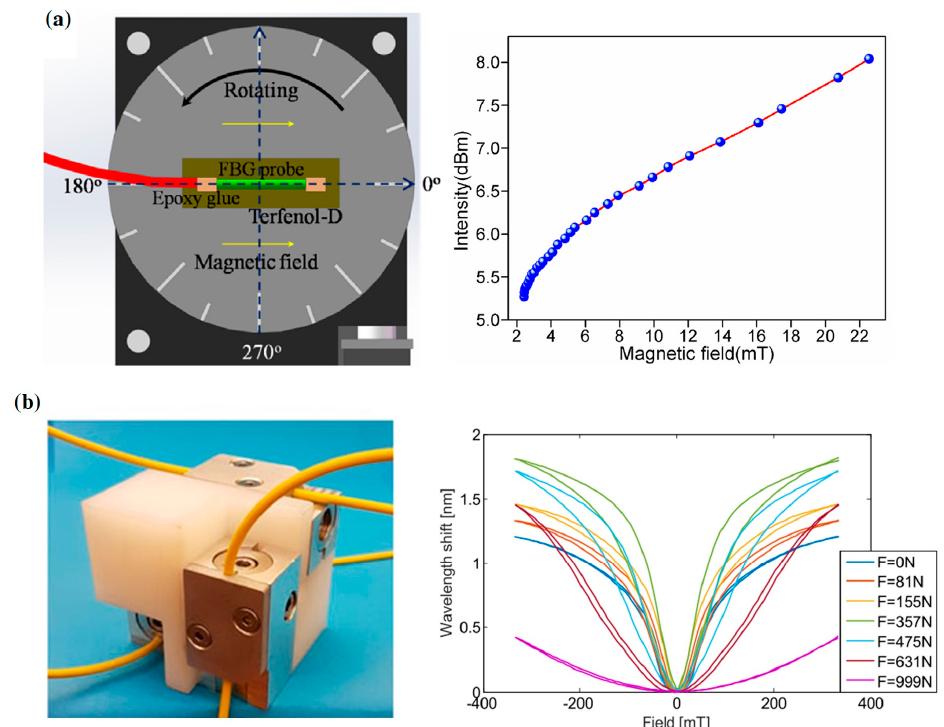
Figure 4. ( a ) Sensor head based on FBG glued on the Terfenol-D bar and the performance of sensor [31] and ( b ) tri-axial sensor and the wavelength shift versus magnetic field curves with di ff erent preloads [32]; permission conveyed through the Copyright Clearance Center,